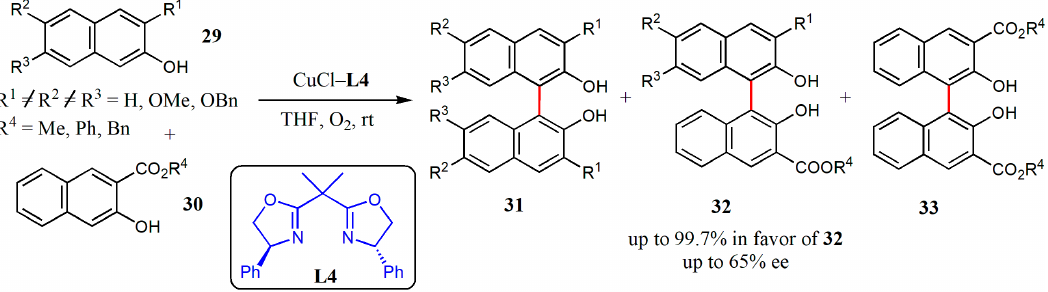
Figure 10. Enantioselective CDC of 2-naphthol derivatives with chiral copper(I)–bisoxazoline catalysts.